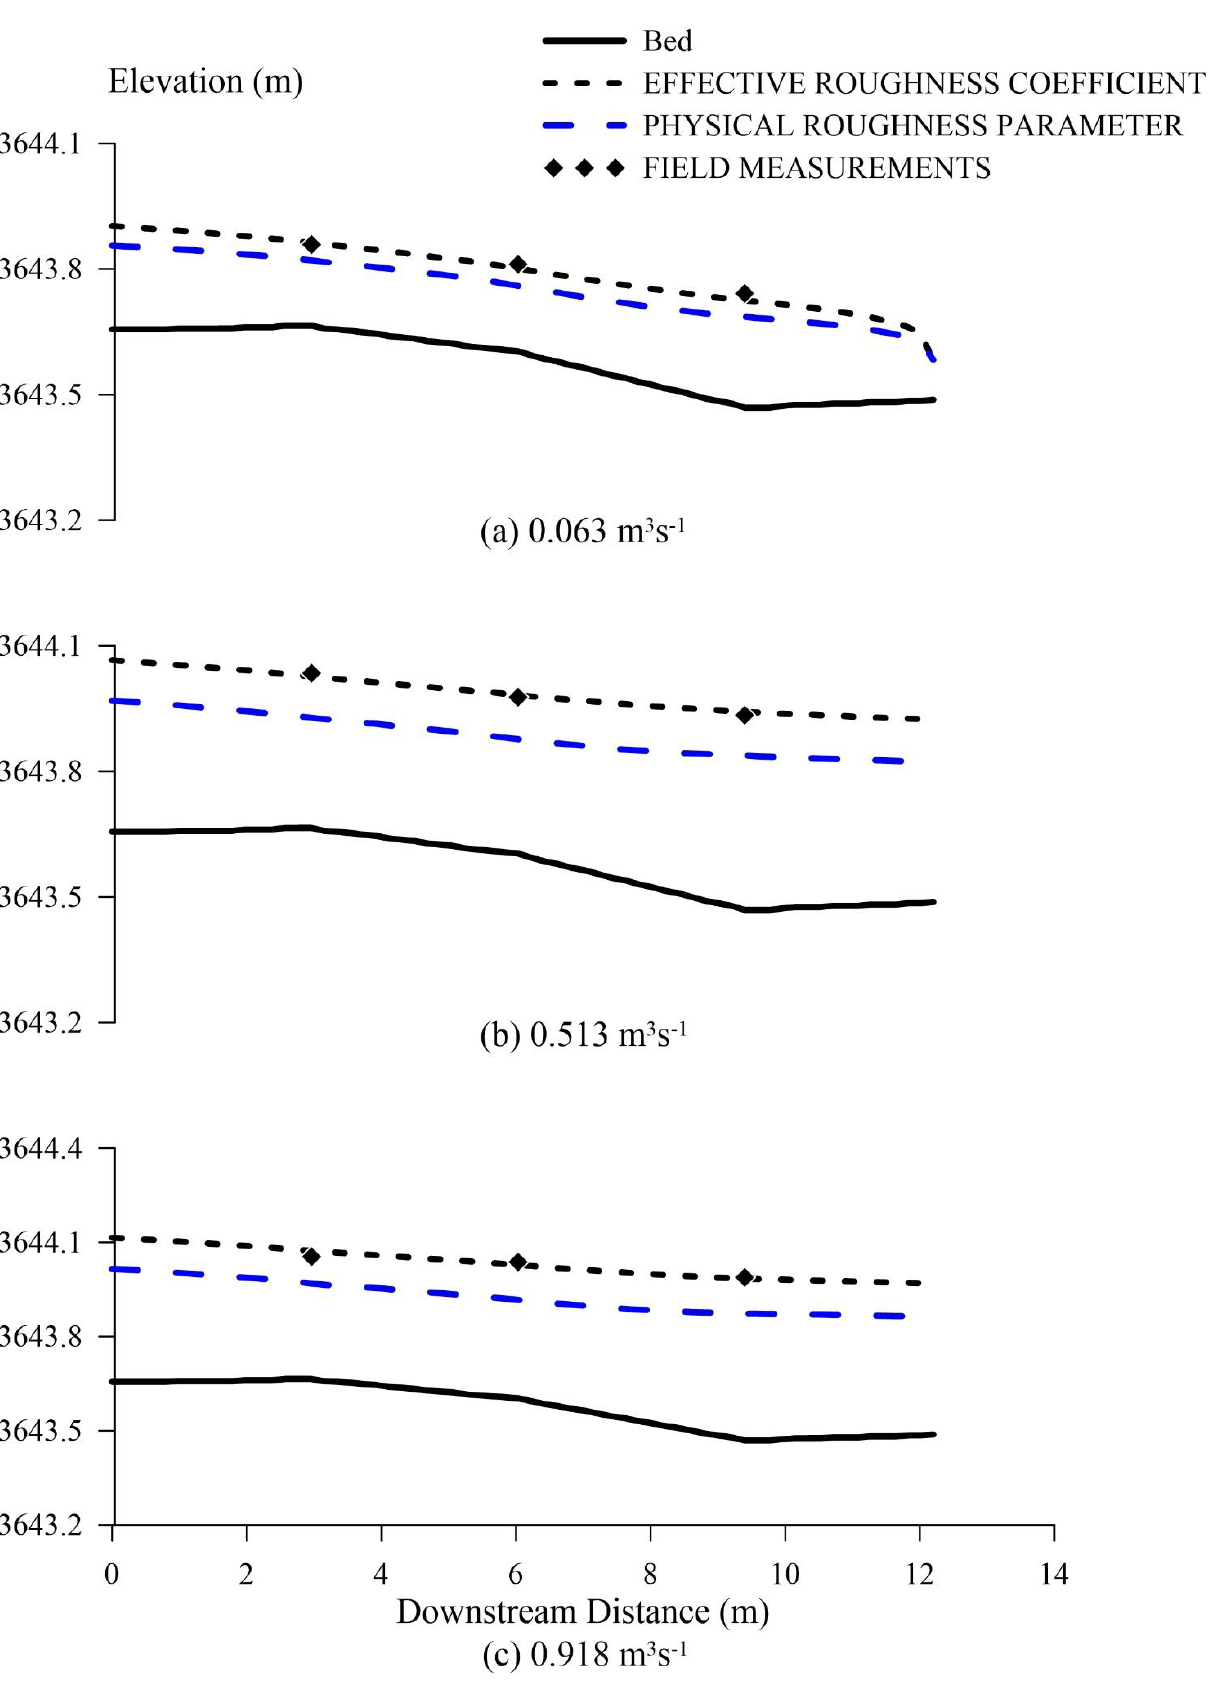
Figure 8. Water surface profiles using ERC and PRP in Plane-Bed. ( a ) 0.063 m 3 s −1 ( b ) 0.513 m 3 s −1 ( c ) 0.918 m 3 s −1 .